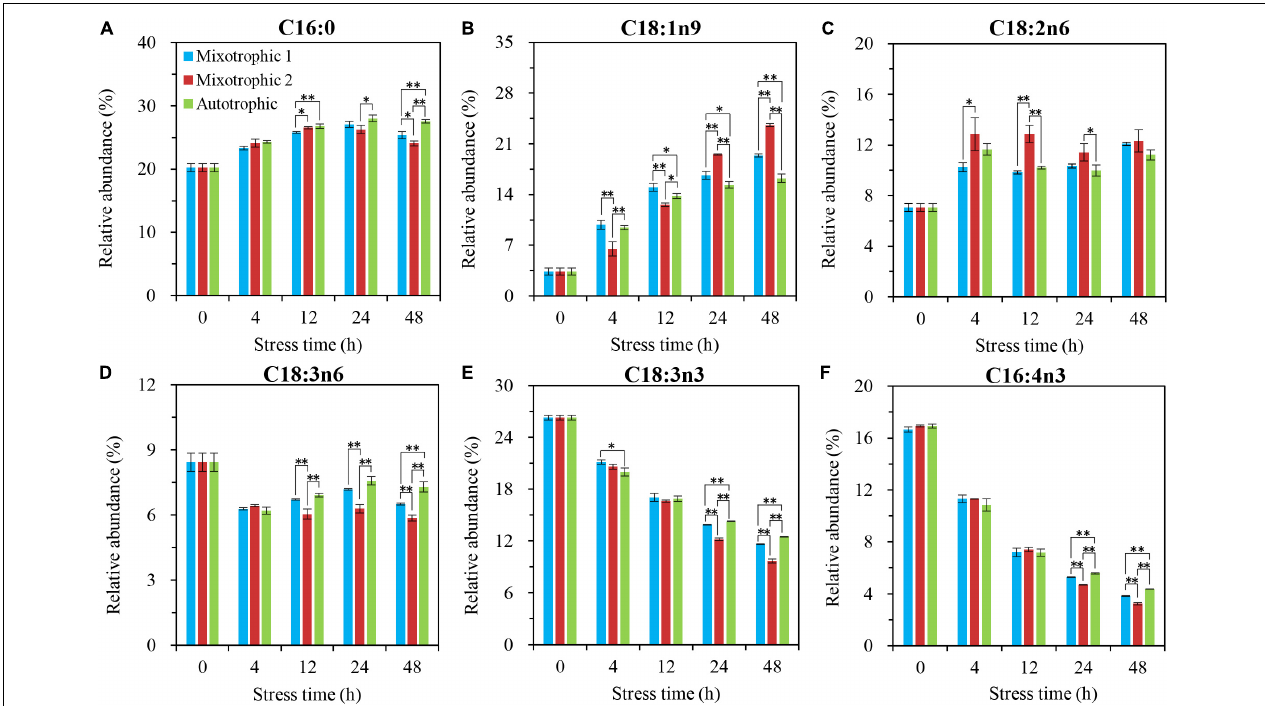
FIGURE 6 | Time course of changes in the relative abundances of the major fatty acyls in C. reinhardtii BAFJ5 under three carbon supply regimes over 48 h of HL-N. The carbon supply regimes for mixotrophic 1, mixotrophic 2, and autotrophic were 17 mM acetate and 2% CO 2 (v/v), 17 mM acetate and ambient 0.04% CO 2 (v/v), and 2% CO 2 (v/v), respectively. Cx:ynz, where x, y, and z refer to the number of carbon, the number of double bonds, and the position of the first double bond counting from the methyl end, respectively. Values are the means of three independent replicates ± SD ( n = 3). ∗ p < 0.05; ∗∗ p < 0.01.